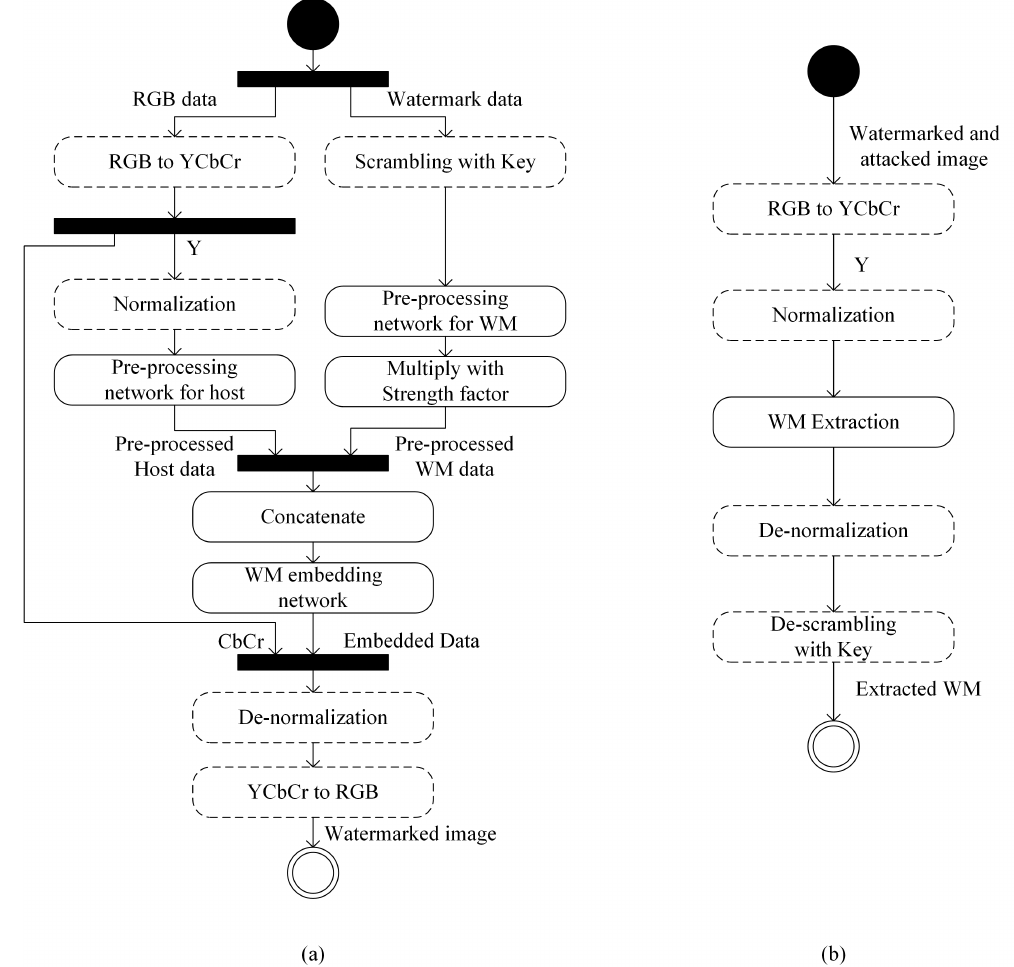
Figure 1. Proposed digital watermarking system: ( a ) watermark embedding, and ( b ) watermark